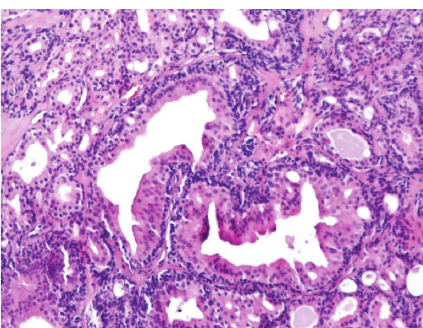
Figure 3: H/E × 100. Two cystic-tubular formations lined by colum- nar cells with an eosinophilic cytoplasm are seen.